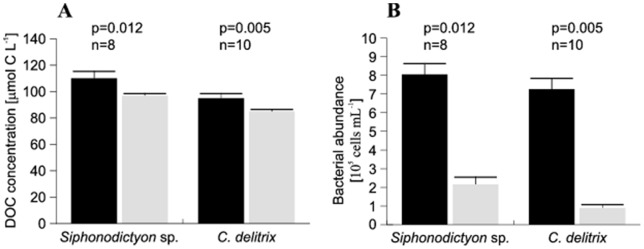
Average DOC (A) and bacterial abundance (B) in the inhaled (black) and exhaled (grey) water of Siphonodictyon sp. and C. delitrix.Error bars indicate SE. P values (Wilcoxon Signed Rank) indicate significance level of the difference in the concentrations between the inhaled and exhaled samples in n pairs of InEx samples.